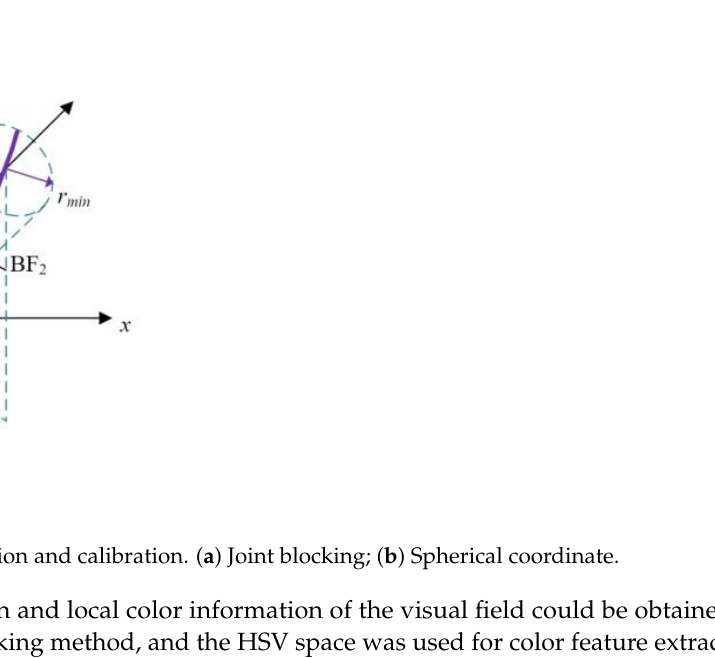
where χ j ( i ) and ψ j ( i ) are local color histogram vectors of the image, i = 1, 2, . . . , m, θ is the average value of the χ 2 distance (BF spacing) of all blocks, and the calculation formula is